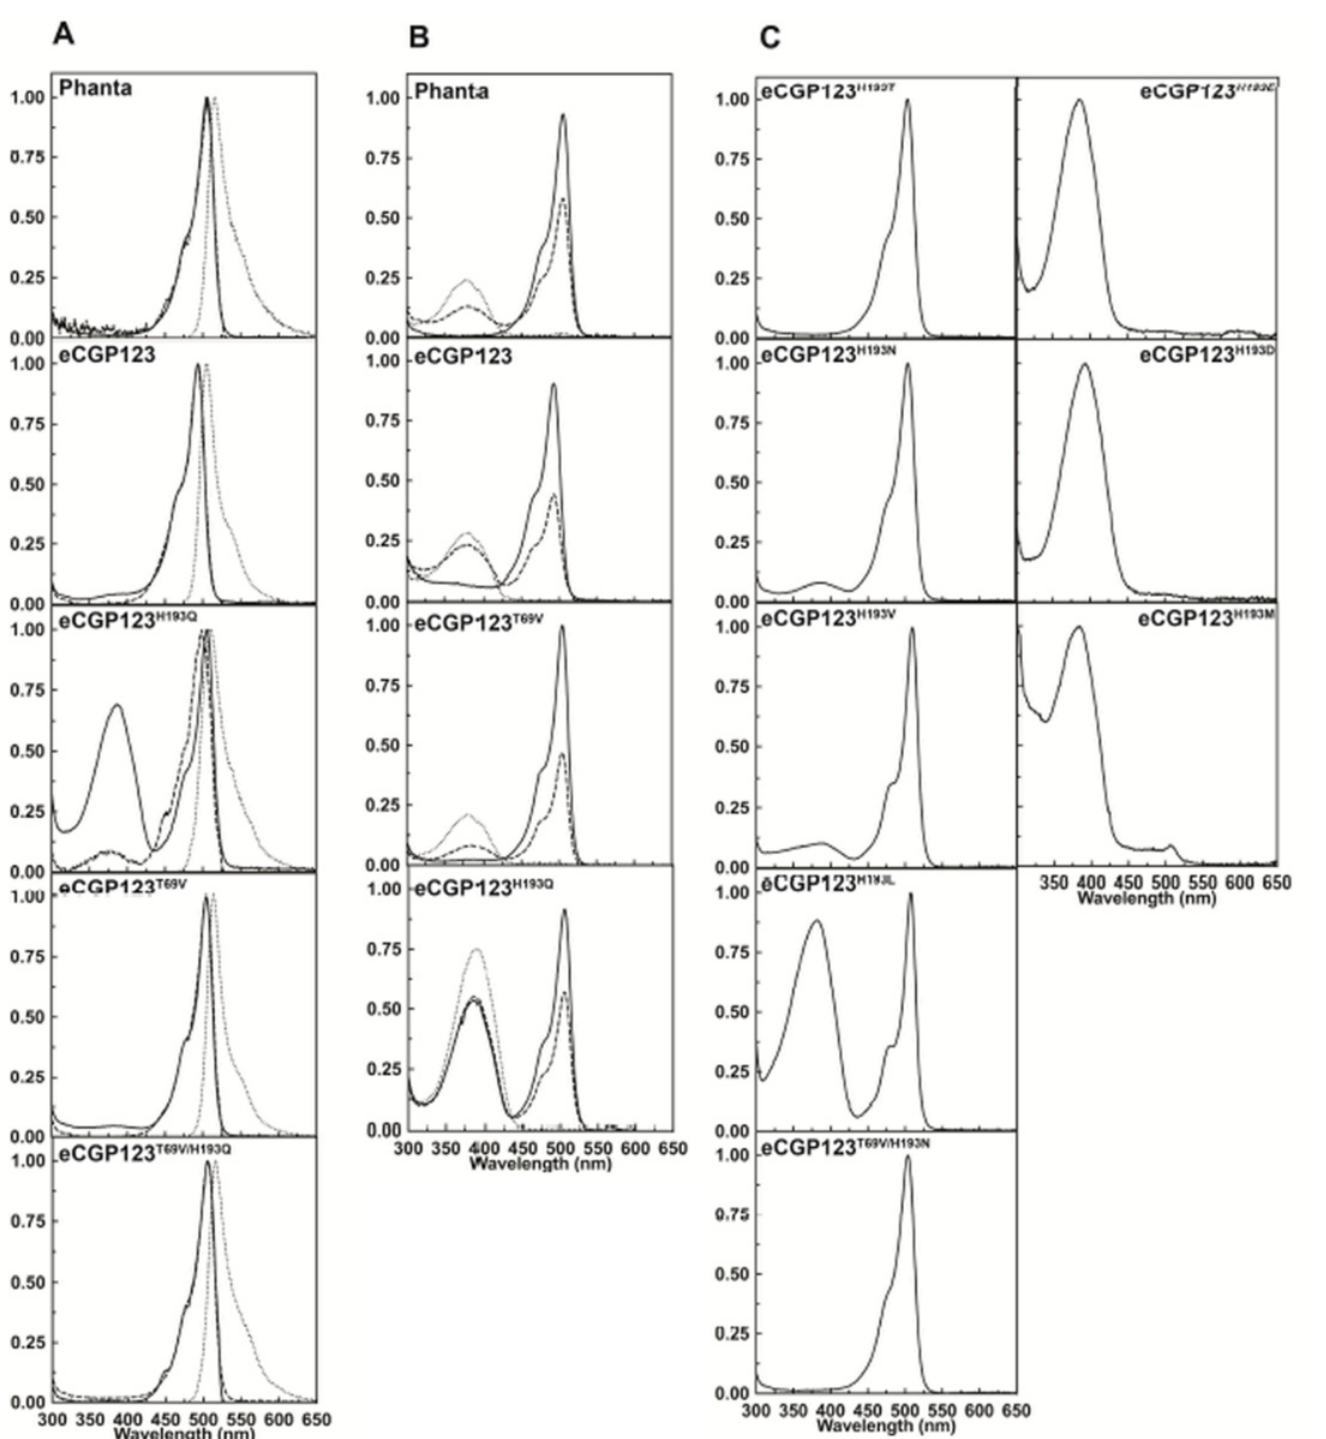
Fig 1. Optical spectra of Phanta and selected variants. (A) Spectra determined at pH 8.0 are shown for Phanta and variants of eCGP123 containing amino acid substitutions that contribute to Phanta. Absorbance (solid line), fluorescence excitation (dashed line) and fluorescence emission (dotted line) are shown. (B) The absorbance spectra are shown for selected variants at pH 8.0 (solid line), pH 6.0 (dashed line) and pH 3.0 (dotted line). (C) Absorbance spectra determined at pH 8.0 are shown for variants of eCGP123 singly substituted at position 193 or doubly substituted at positions 193 and 69.